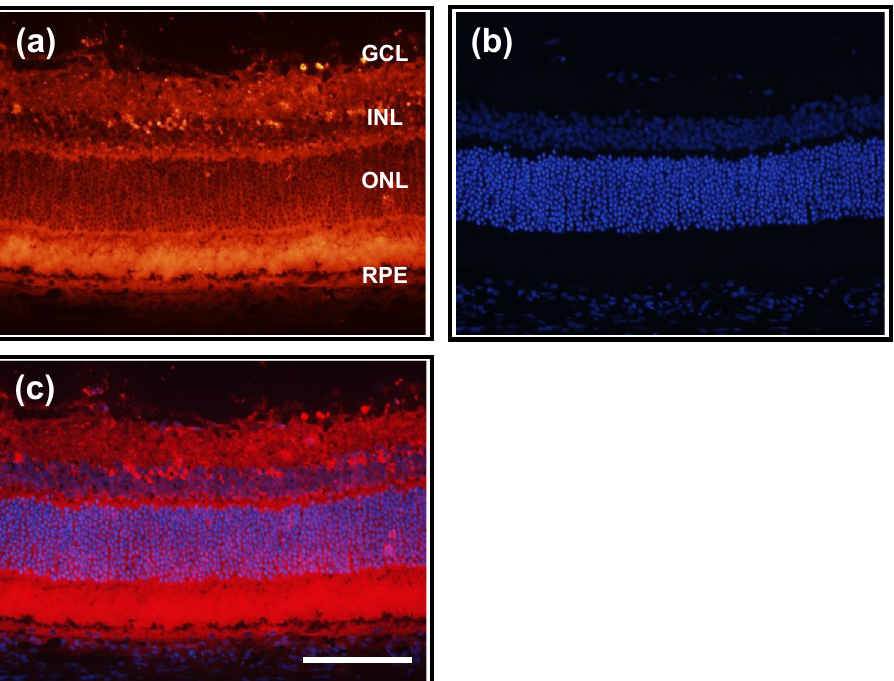
Figure 3. Spatial distribution of fluorescence-labeled Accell siRNA following intravitreal injection in the rat retina. Histological analysis of retinal tissues was performed 3 days after intravitreal injection of fluorescence- labeled negative control siRNA (2 nmol/eye). ( a ) siRNA; ( b ) DAPI staining; ( c ) Merge of siRNA and DAPI images. The scale bar represents 100 μm. GCL ganglion cell layer, INL inner nuclear layer, ONL outer nuclear layer, RPE retinal pigment